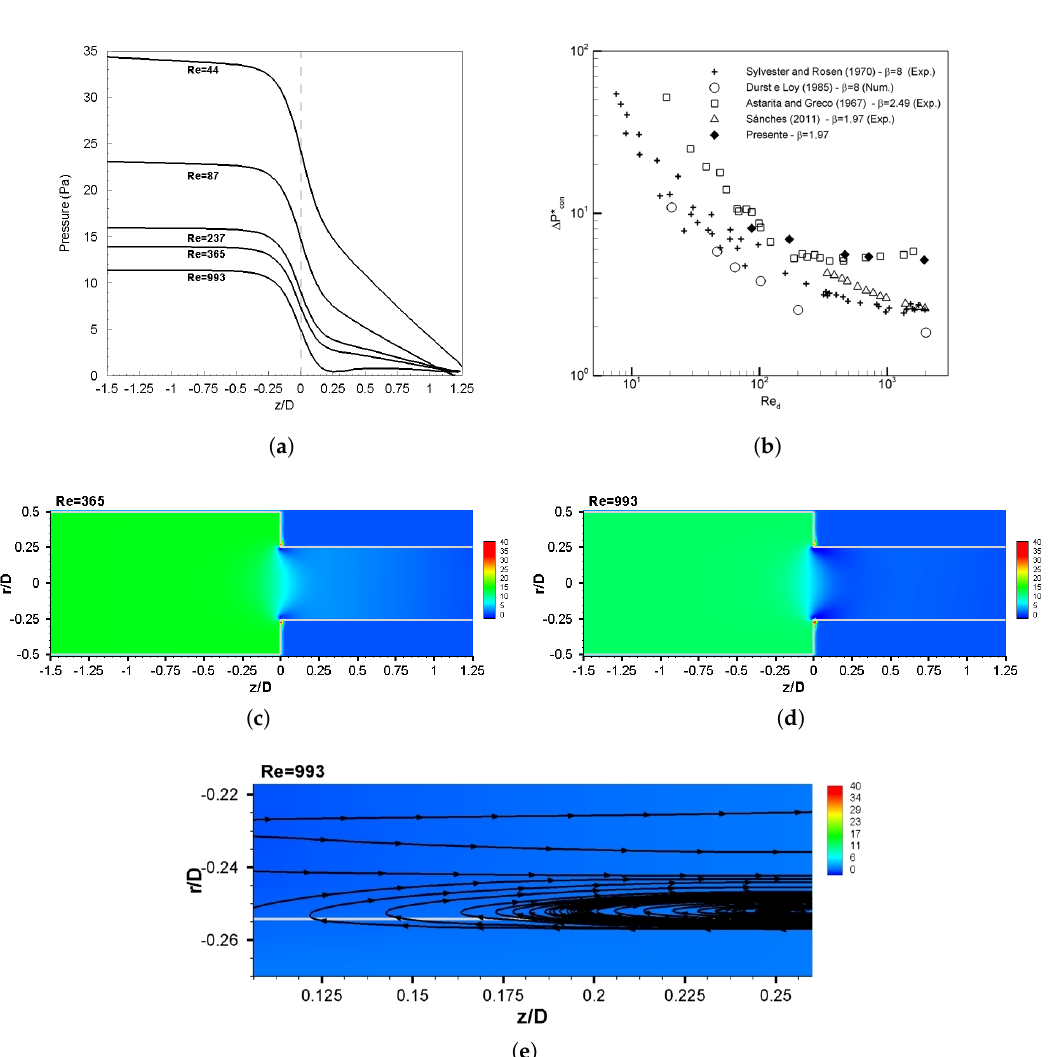
Figure 5. Pressure ( a ) distribution along the centreline at various Re D , ( b ) pressure loss, ( c ) pressure fields at Re D = 365, ( d ) pressure field at Re D = 993 and ( e ) vena contracta evidence at Re D = 993 (zoom in on the pressure